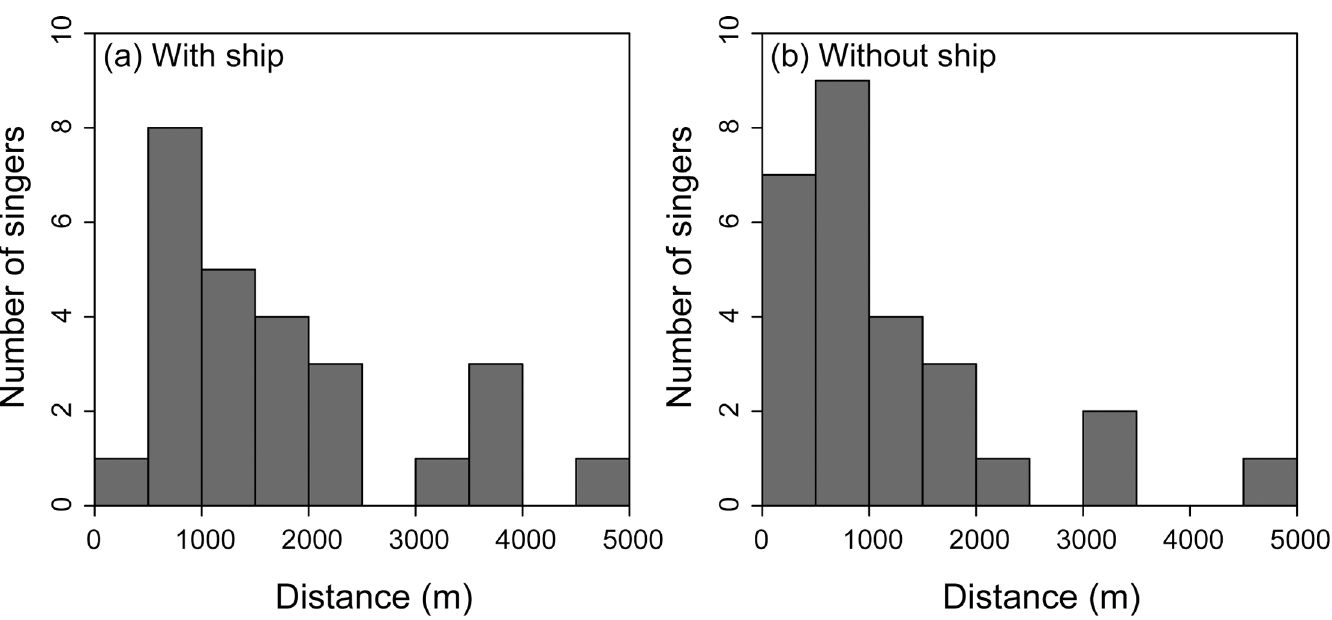
Fig 5. The nearest distance between the singers and the ship trajectory. The estimated location of each singer from 7:30 to 8:00 am that were used in the calculation. The mean of distance (a) with the ship was 1758 m, and (b) without the ship was 1210 m. The number of singing whales observed in each distance bin gradually reduced. Only one singer was found within 500 m from the ship trajectory on the day with the ship operating, wheras 7 singers were found on the day with no ship